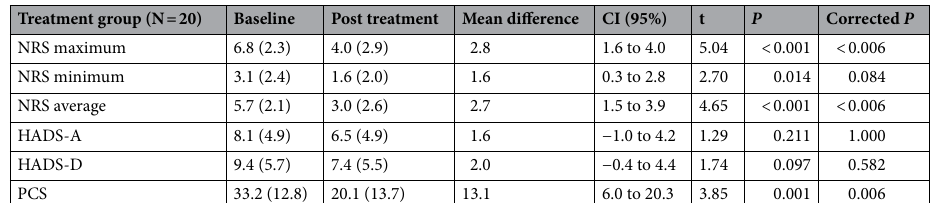
Treatment group (N =